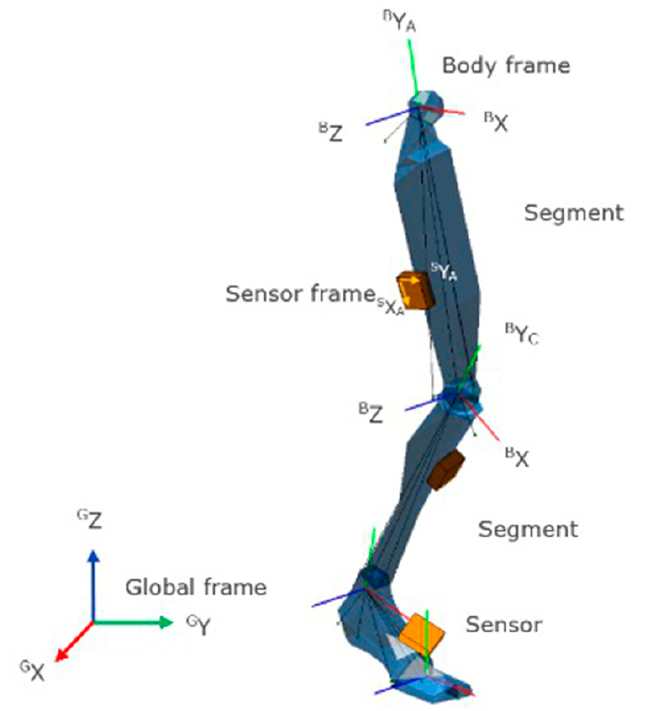
Figure 2. Xsens sensor reference frames and segment reference frames [40].